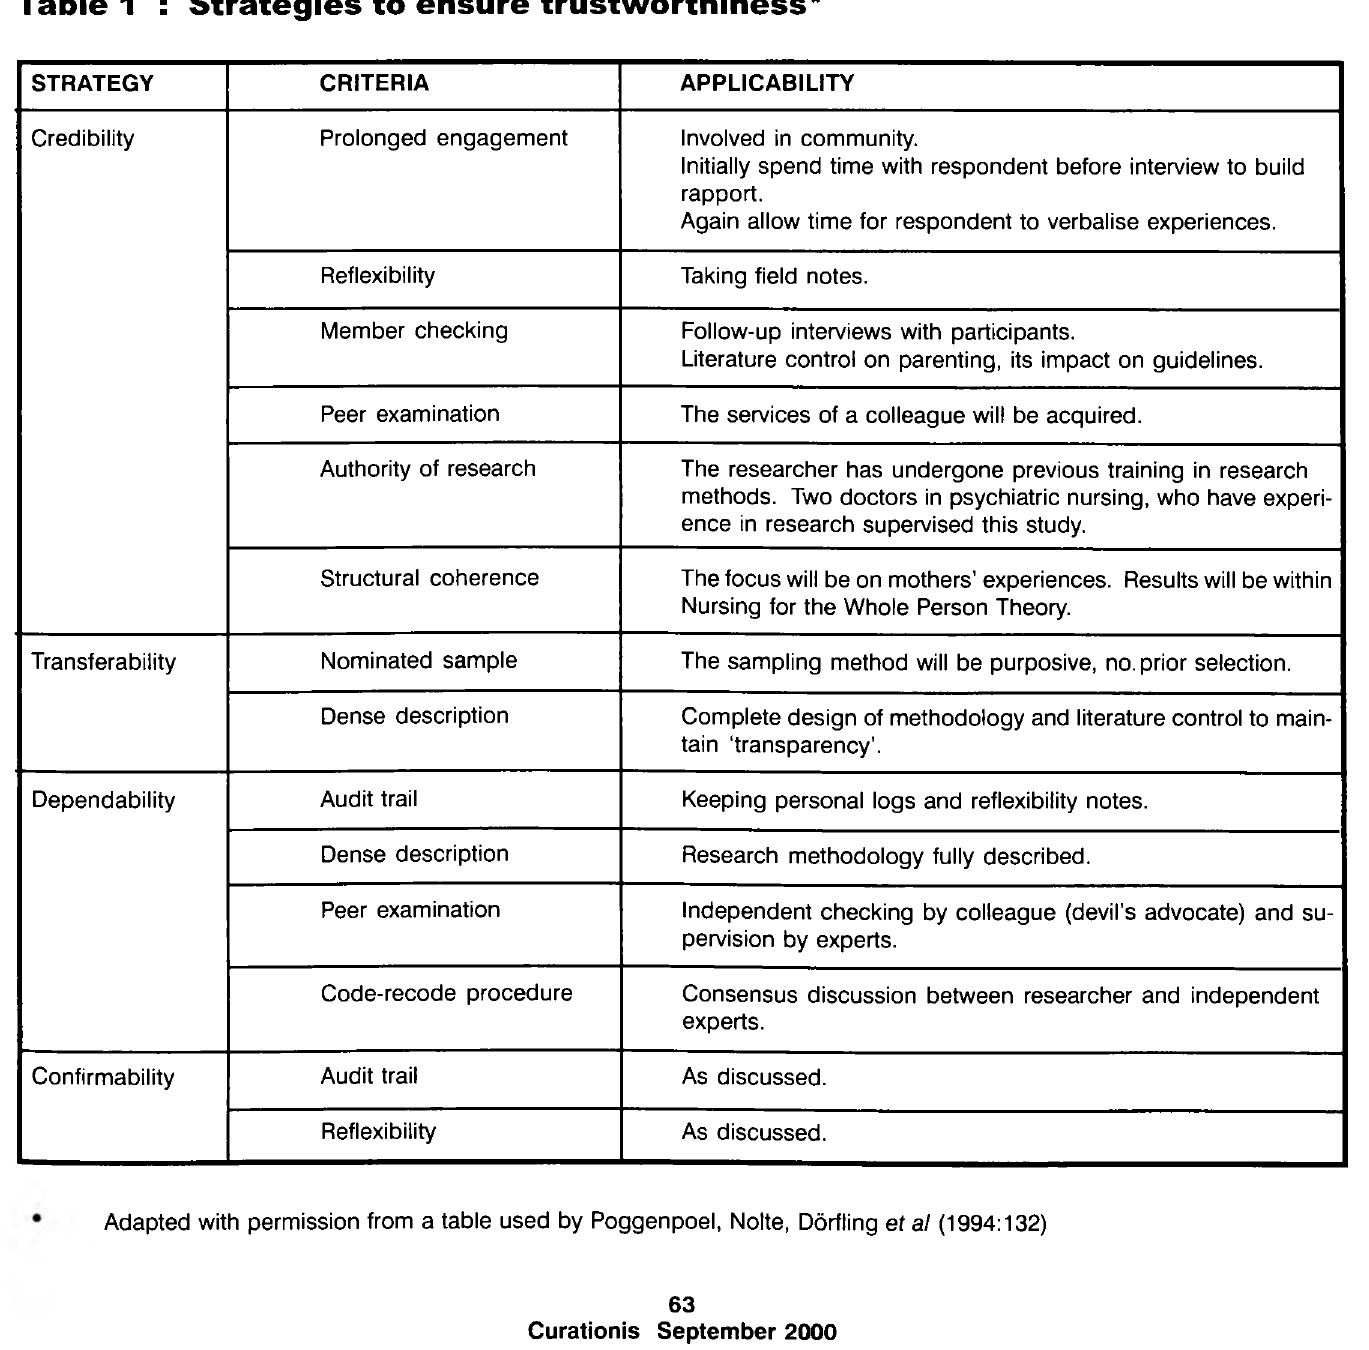
Table 1 : Strategies to ensure trustworthiness*